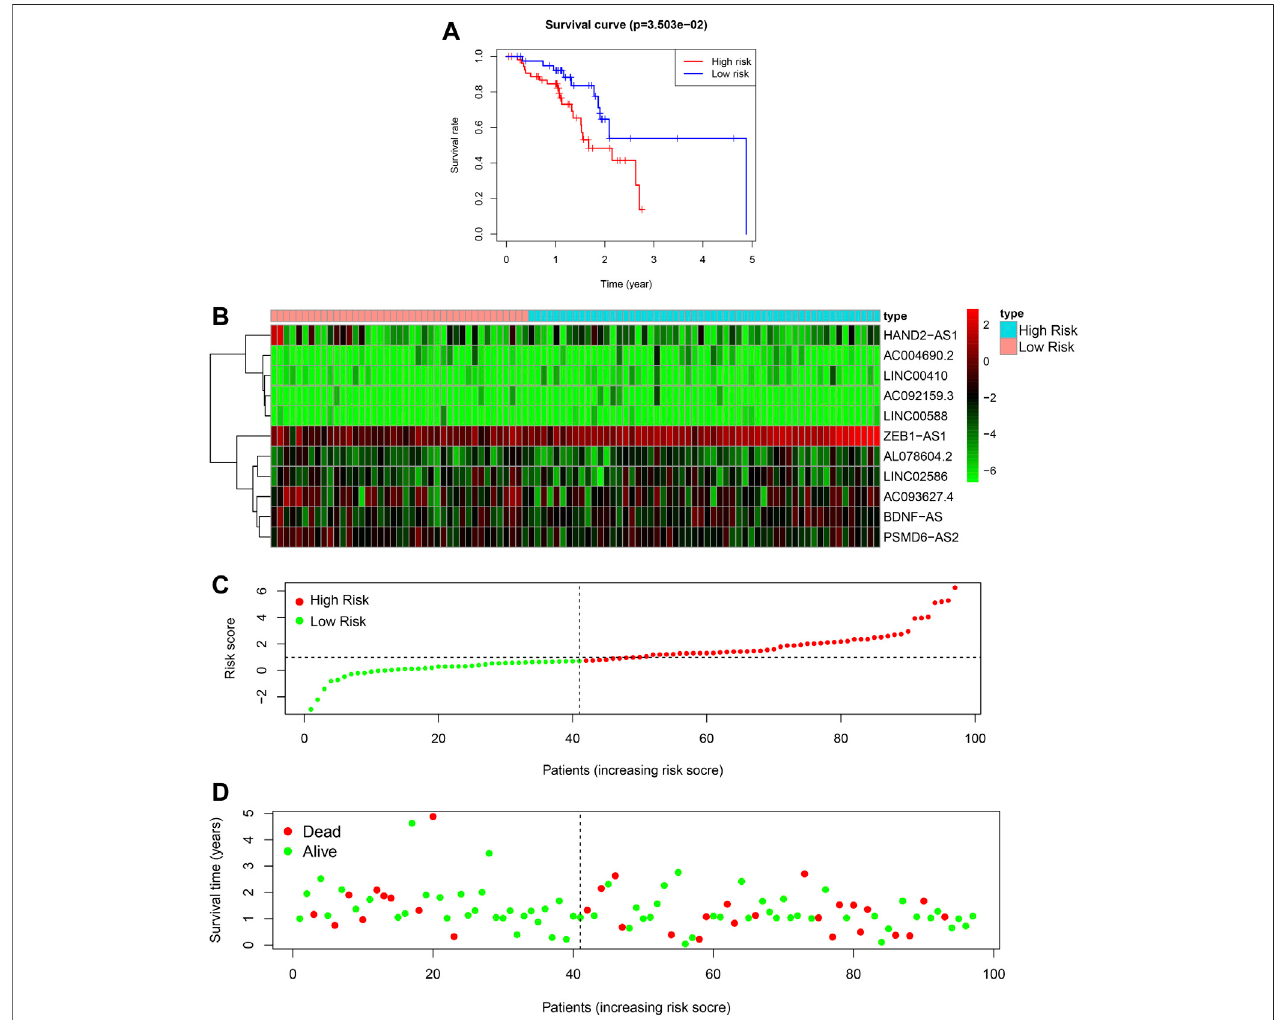
FIGURE4| AutophagyrelatedlncRNAriskmodelintheTCGAtestingset. (A) :SurvivalcurveofESCCpatientsbasedontheriskvalue, (B) :Expressionheatmapof the 11 lncRNAs in patients, (C) : Patients distribution based on the risk value, (D) : Survival status of all ESCC patients.